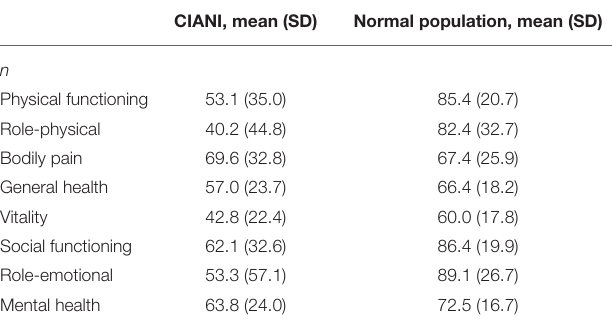
TABLE 5 | Results of SF-36 health-related quality of life questionnaire of patients after treatment with continuous intra-arterial nimodipine infusion. CIANI, mean (SD) Normal population, mean